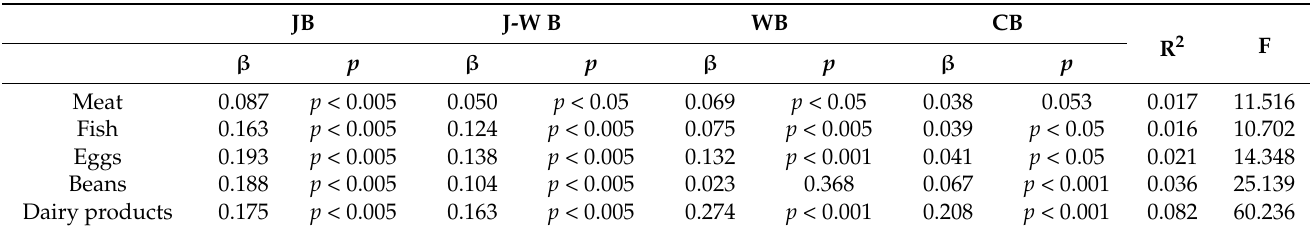
Table 1. Results of multiple regression analysis of the relationship between breakfast style and protein source intake.